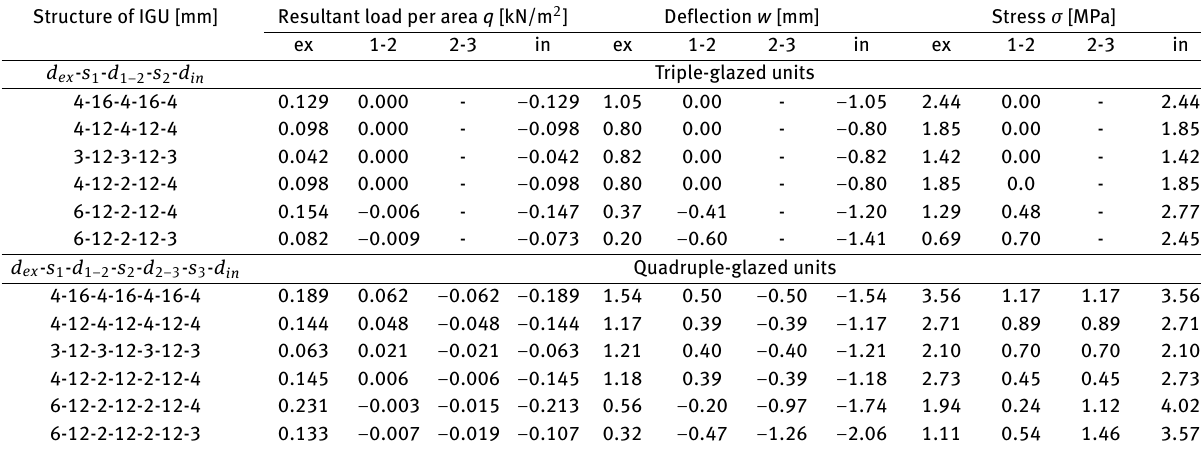
Table 2: Static values in component glass panes - increase of atmospheric pressure by 3 kPa. Structure of IGU